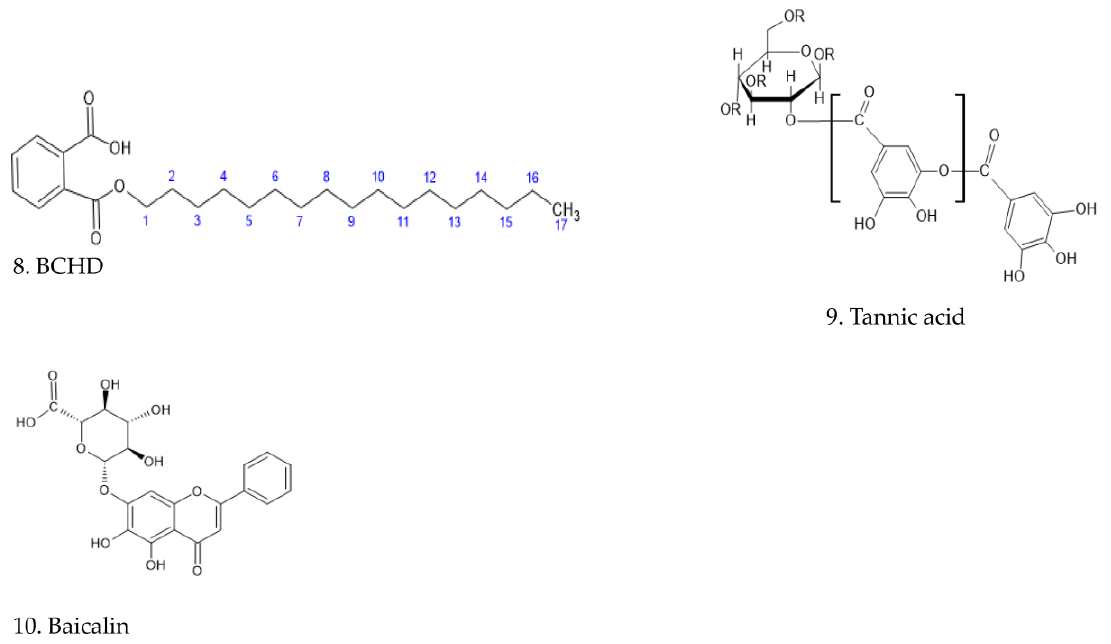
Figure 8. Structure of benzene-1-carboxylic acid-2- hexadeconate (BCHD (8)), tannic acid (9), and baicalin (10) .